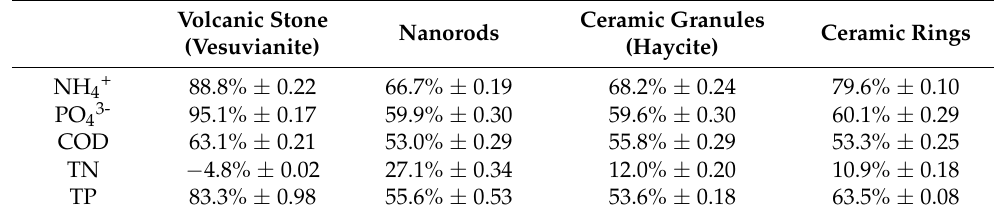
Table 1. Average purification efficiencies of different substrate materials (mean ± standard deviation).